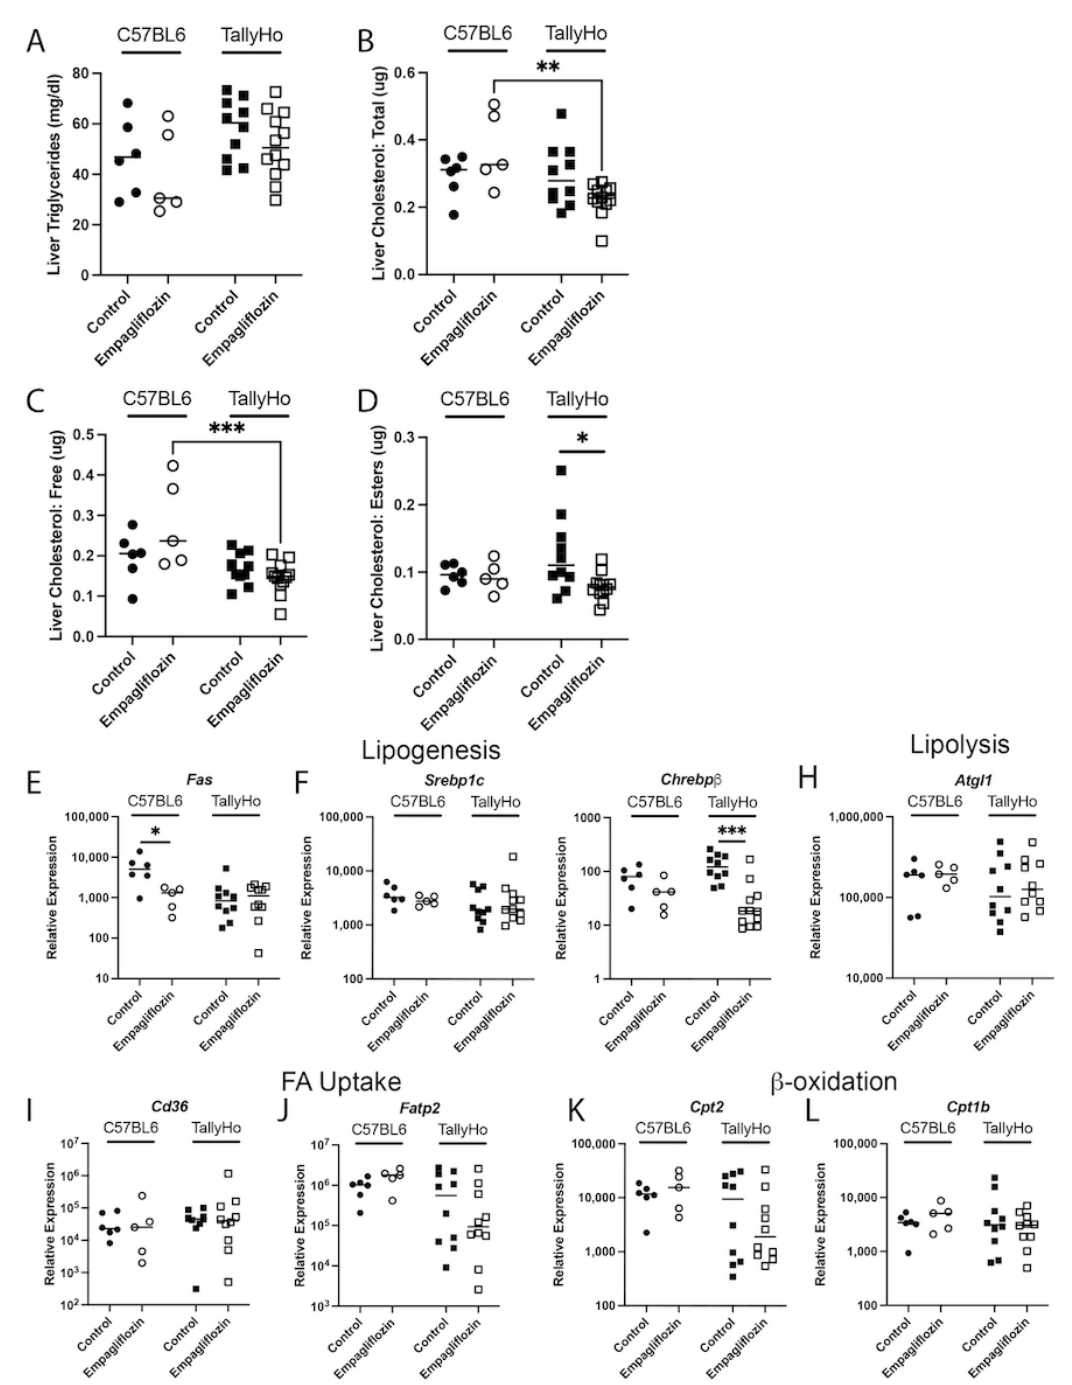
Figure 6. Empagliflozin attenuates hepatic cholesterol esters in male TallyHo mice. Livers from control and Empagliflozin-treated C57BL6J and TallyHo mice were isolated, lysed, and analyzed for total triglycerides ( A ), total cholesterol ( B ), free cholesterol ( C ), and cholesterol esters ( D ). Additionally, RNA was isolated and reverse transcribed to cDNA to perform qPCR for enzymes involved in lipogenesis ( E – G ), lipolysis ( H ), fatty acid (FA) uptake ( I , J ), and β -oxidation ( K , L ). * p < 0.05 between control and Empagliflozin-treated mice. ** p < 0.005 and *** p < 0.0005 between C57BL6J and TallyHo mice.